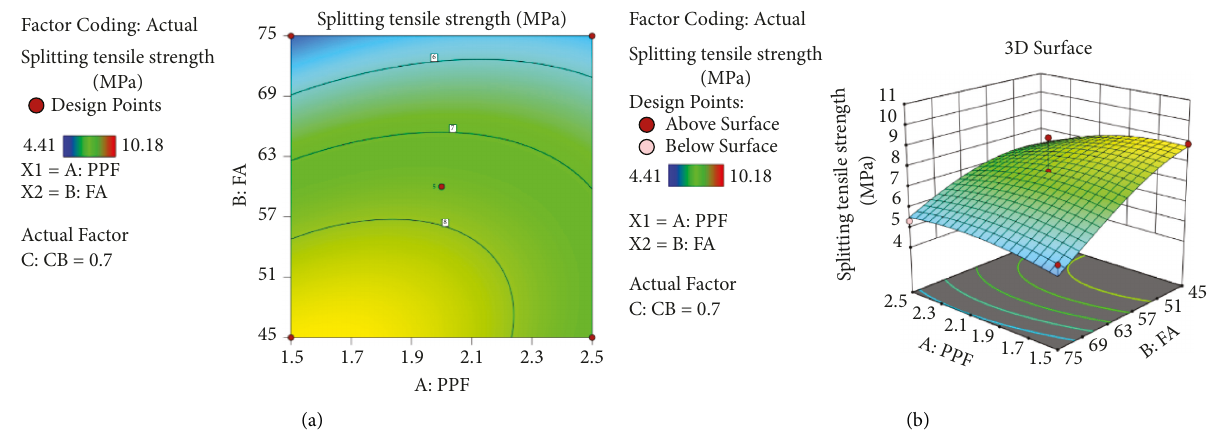
Figure 14: Contour plot of splitting tensile strength. (a) R4 and (b) 3D graph of R4. Table 5: Definition of factors and responses in the process of multiobjective optimization.